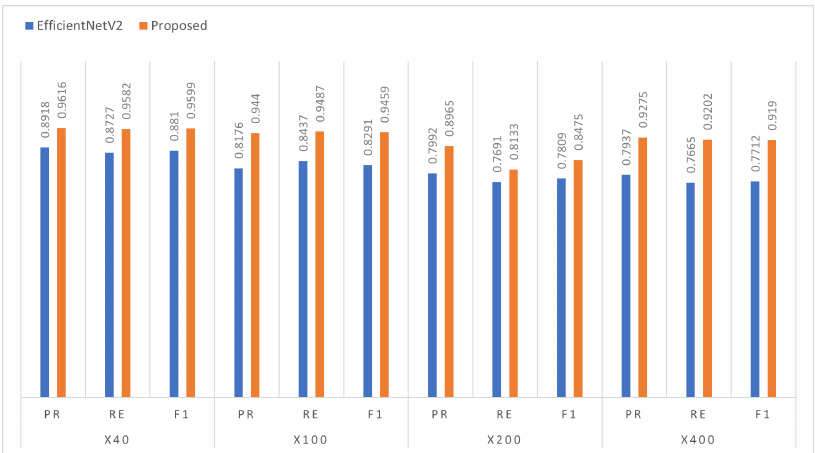
Figure 6. Illustration of the proposed model multi-class classification performance improvement respective to